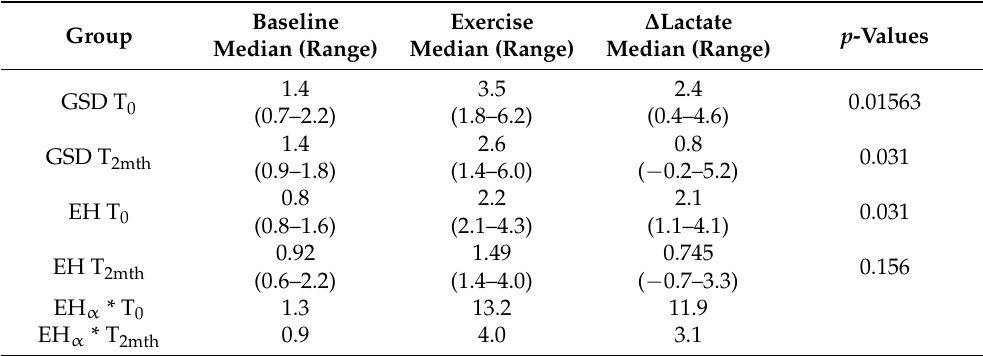
Table 3. Plasma lactate concentration (mmol/L) in GSDs and EHs before and after exercise, before